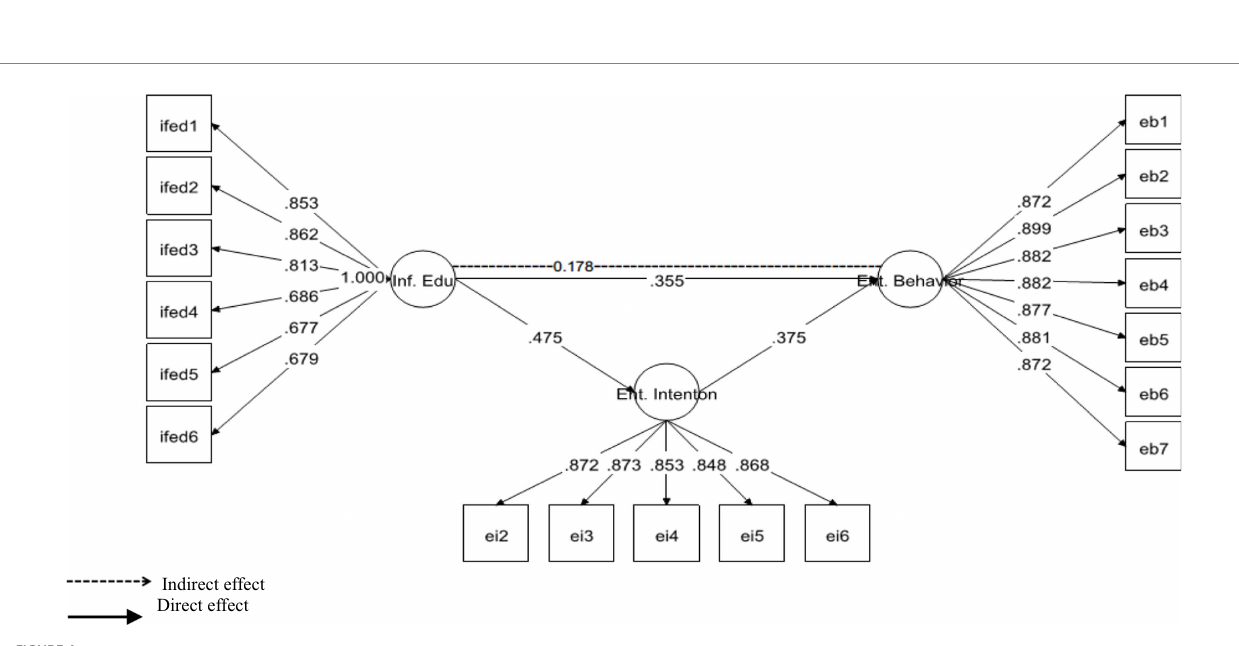
FIGURE 4 Mediation of entrepreneurial intention (Ent. Intention) between informal education (Inf. Edu) and entrepreneurial behavior (Ent. Behav).